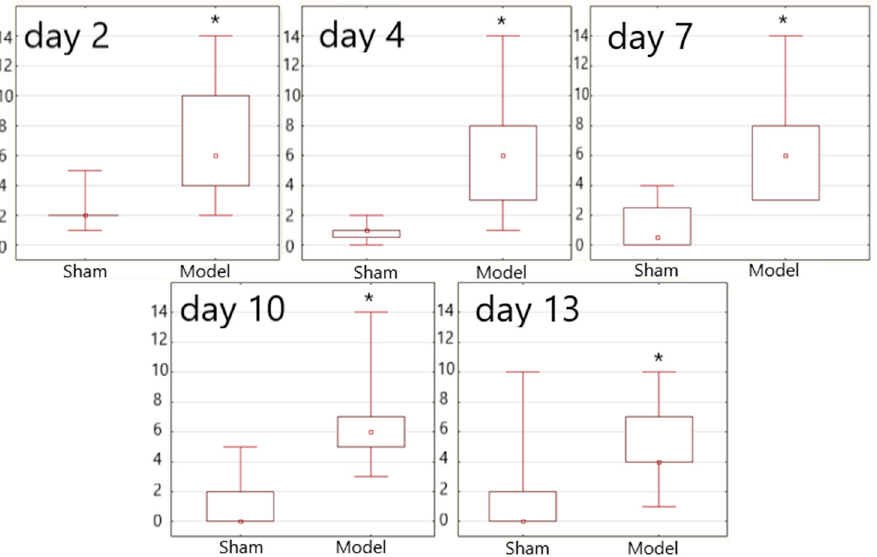
Figure 4. Neurological deficit analysis according to [35]. The data are presented in the form of a swing plot with P25–P75 boundaries and marks of the minimum and maximum values of the dataset. * p < 0.05 in comparison to Group 2—Sham animals.